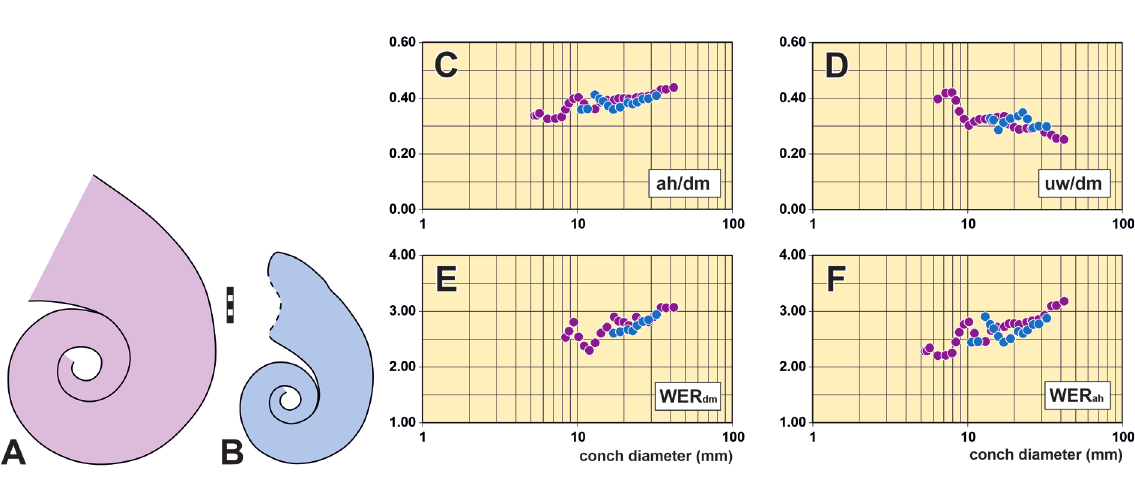
Fig. 74. Cyclolituites lynceus Holm, 1891. A . Coiling outline of specimen MB.C.30561. B . Coiling outline of specimen MB.C.30562. C–F . Conch proportions and coiling rates of the specimens MB.C.30561 and MB.C.30562. Scale bar units = 1